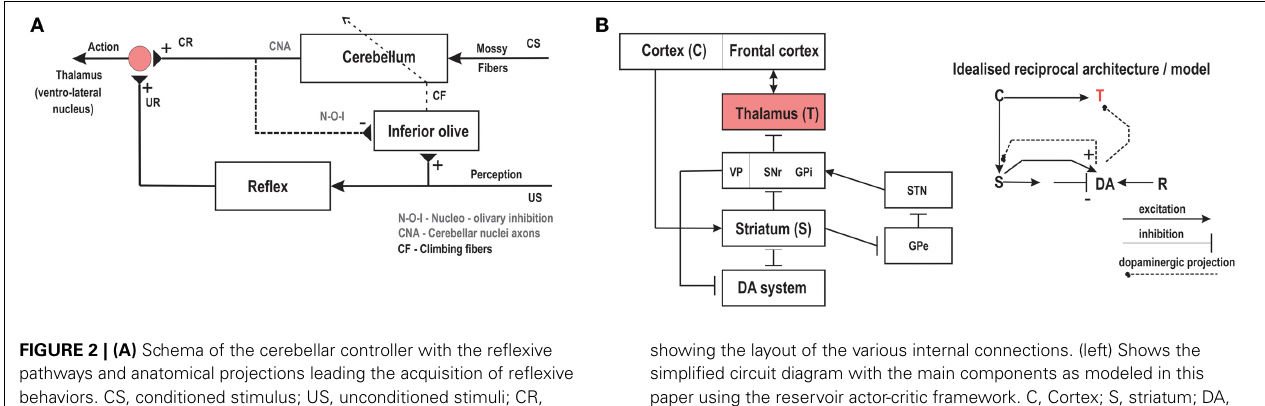
showing the layout of the various internal connections. (left) Shows the simplified circuit diagram with the main components as modeled in this paper using the reservoir actor-critic framework. C, Cortex; S, striatum; DA, dopamine system; R, reward; T, thalamus. Adapted and modified from Wörgötter and Porr